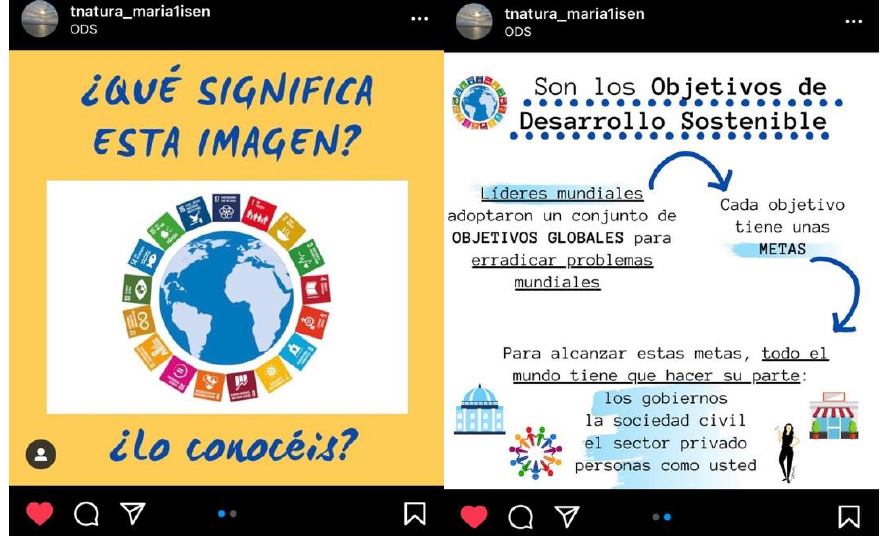
Figure 3. Example of images used by the students on Instagram.